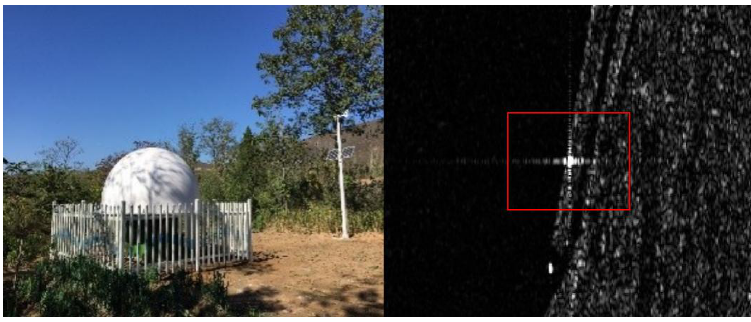
Figure 5. Appearance of the corner reflector ( left ) and its image performance ( right ).